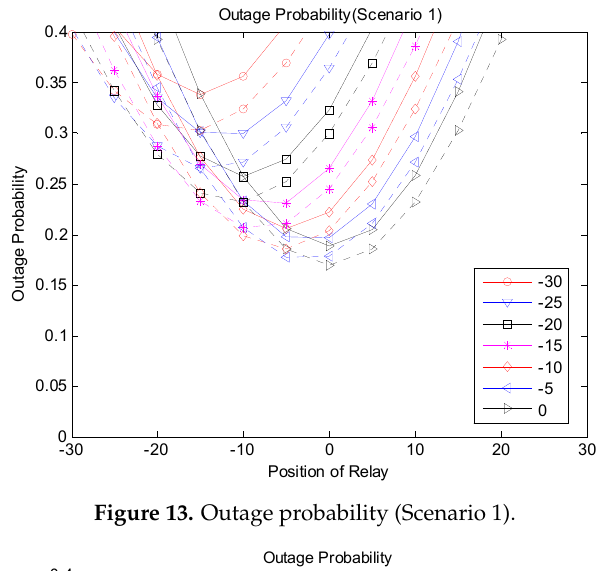
Figure 13. Outage probability (Scenario 1).